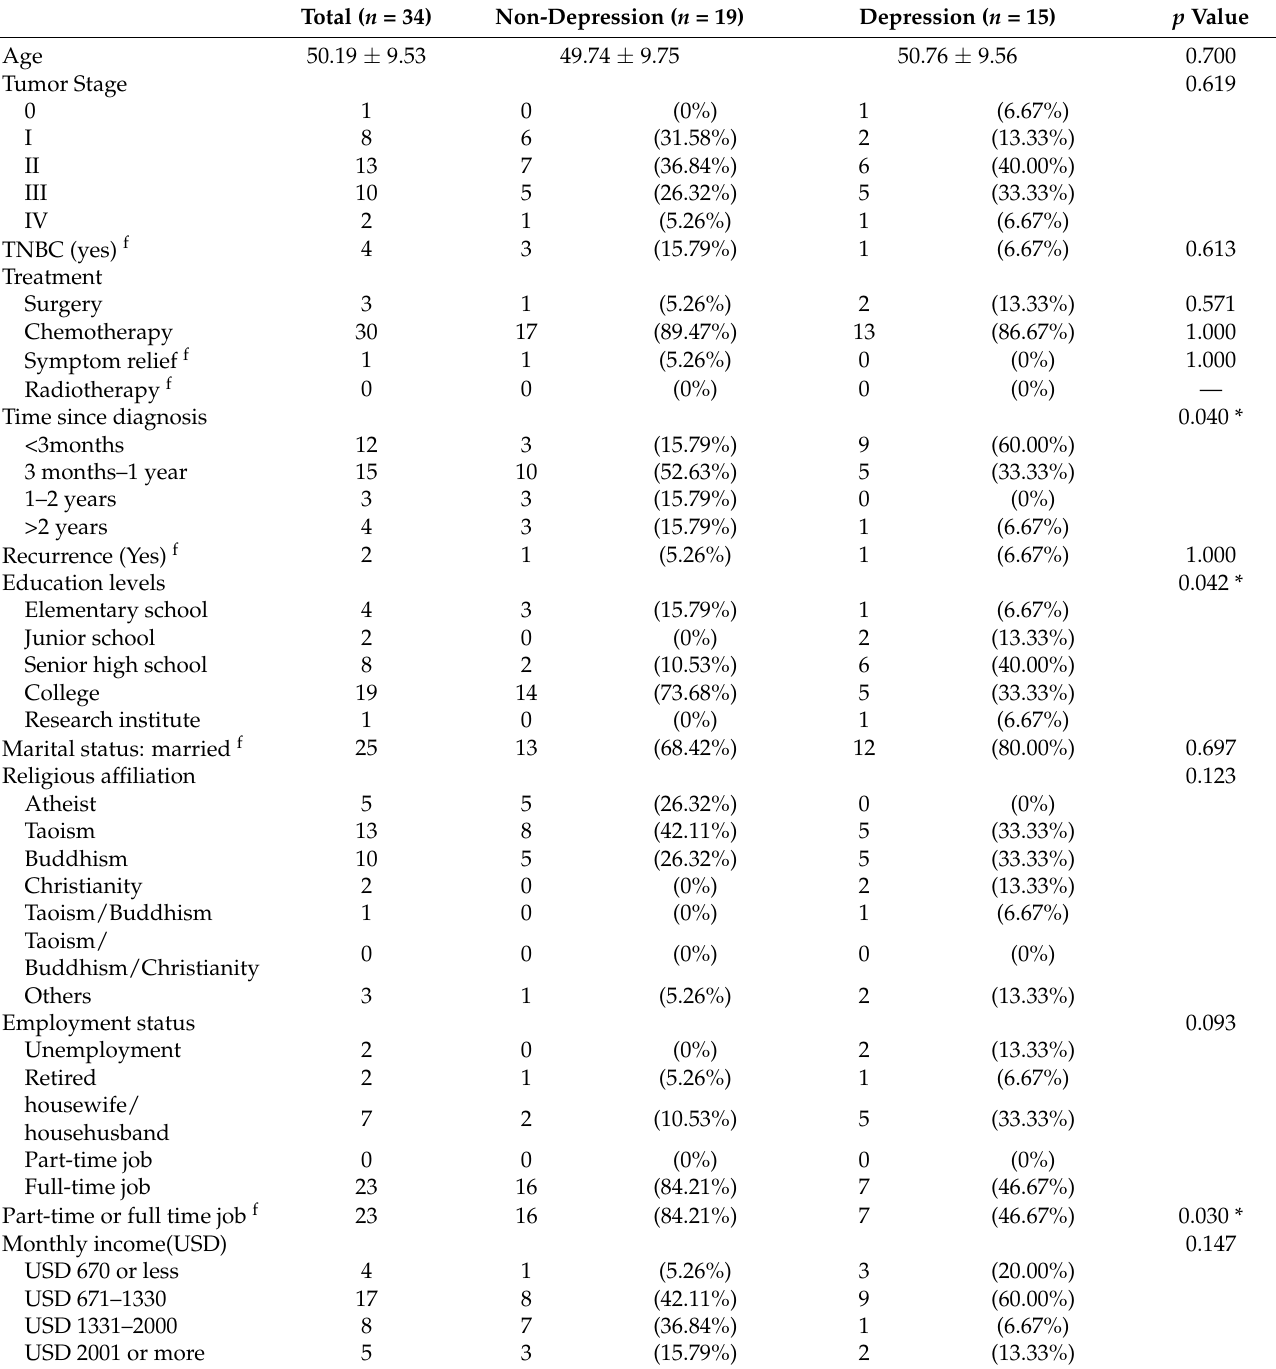
Table 4. The associations between sociodemographic characteristics and depression in the high- demoralization